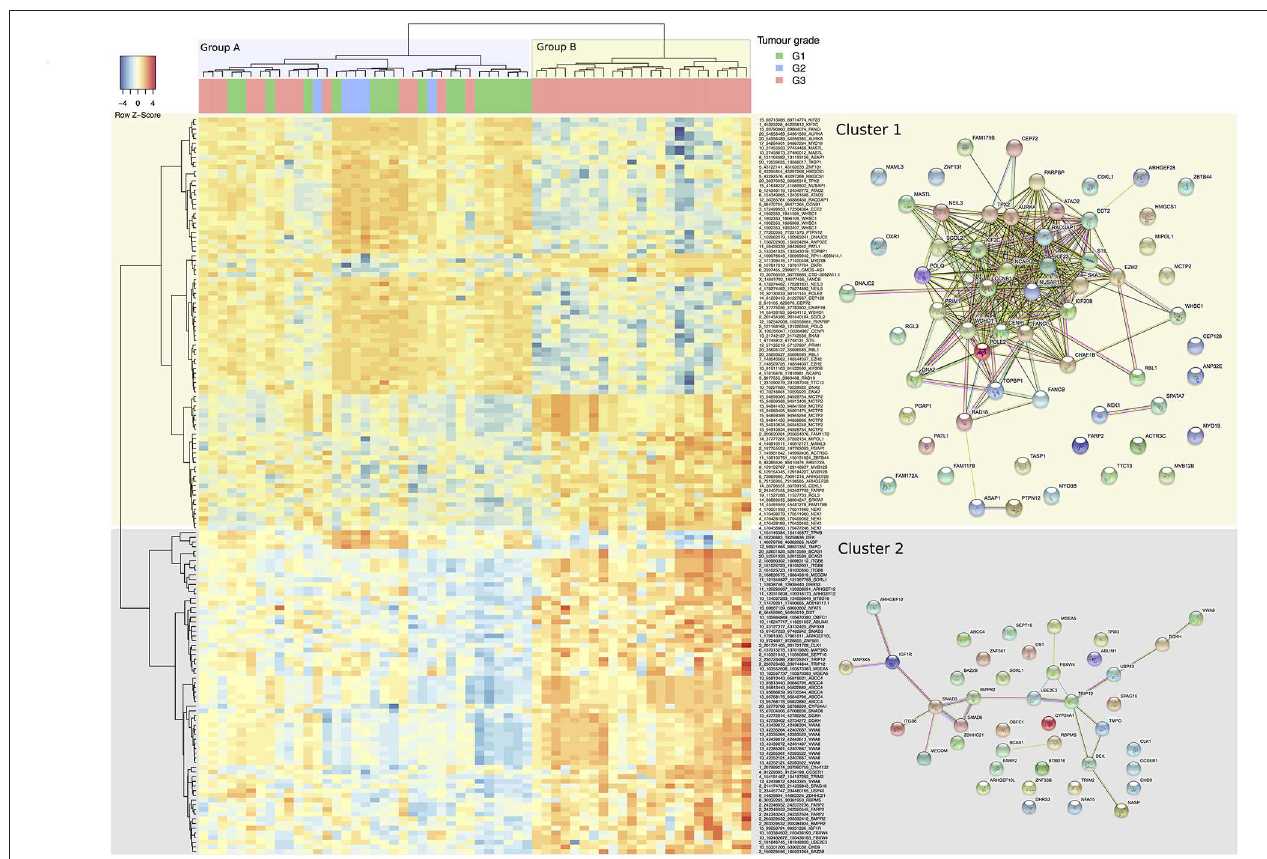
FIGURE 3 | Heatmap representation of hierarchical clustering for 157 differentially expressed circular RNAs (Y-axis) by the 58 tumor samples across G1, G2, and G3 tumor grades (X-axis). Each cell value is the circular-to-linear ratio of an individual circRNA in a given tumor sample. The two main groups of samples branching out in the cluster representation are discussed in the text are color coded in the x-axis (Group A and B), and the two main clusters of circRNAs (Cluster 1 and 2) on the y-Axis. On the right, STRING sub-networks are pictured to illustrate functional connectivity between the parental genes of the circles. Individual functional enrichments of these groups are listed in Supplementary Table 1